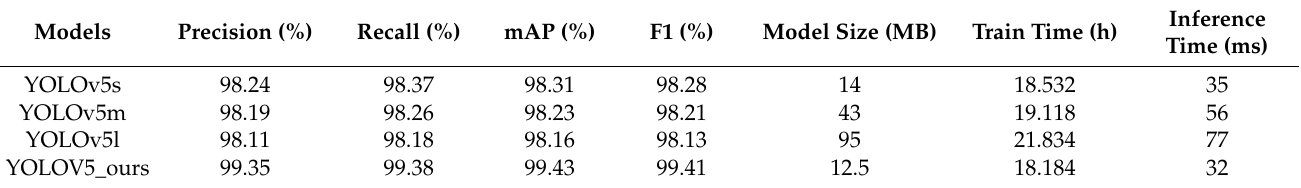
Table 5. The performance results of different YOLOv5 detection